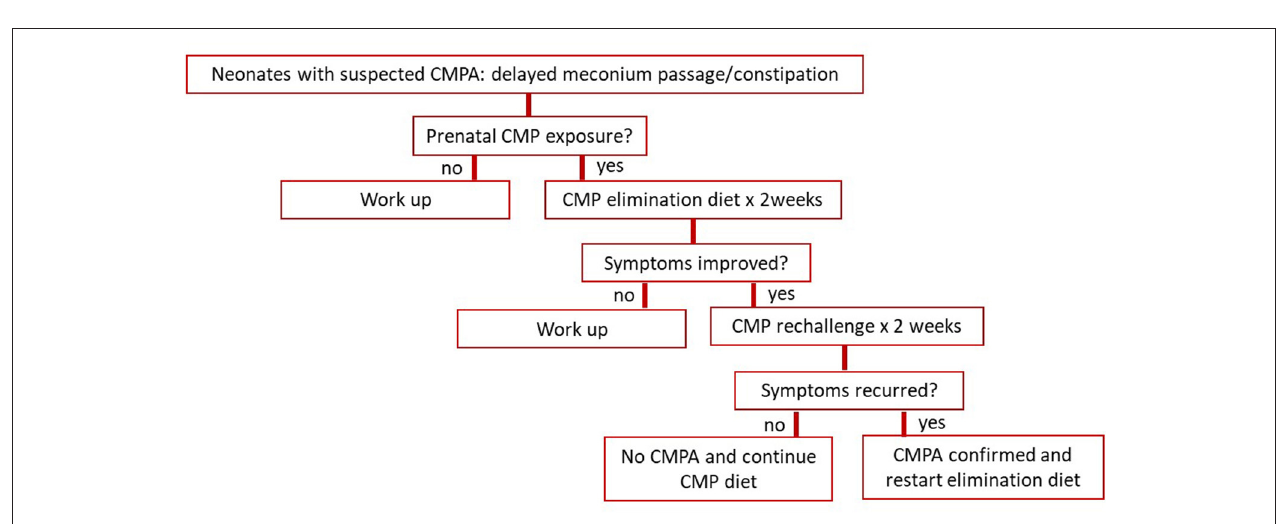
FIGURE 3 | Proposes a management algorithm for early-onset constipation in neonates with suspected CMPA. CMP, cow’s milk